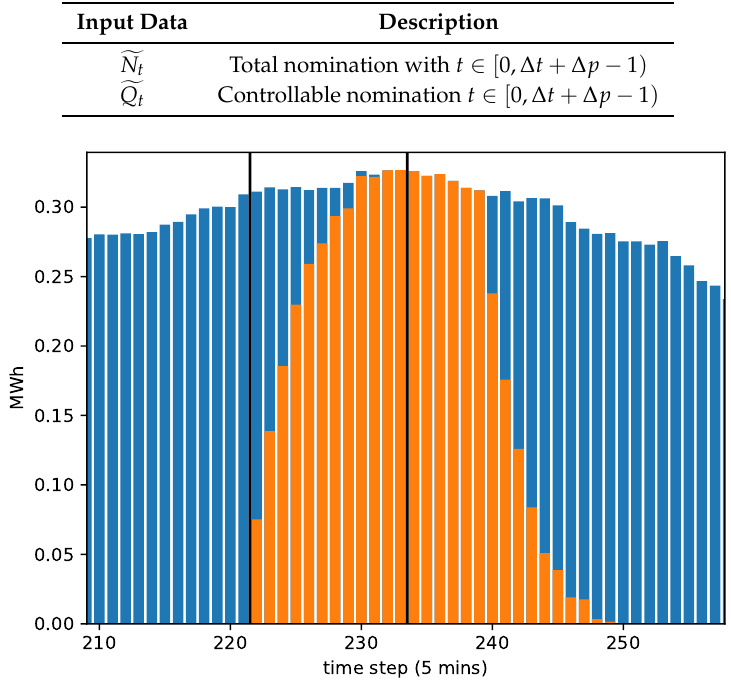
Table 2. Initial nomination data.